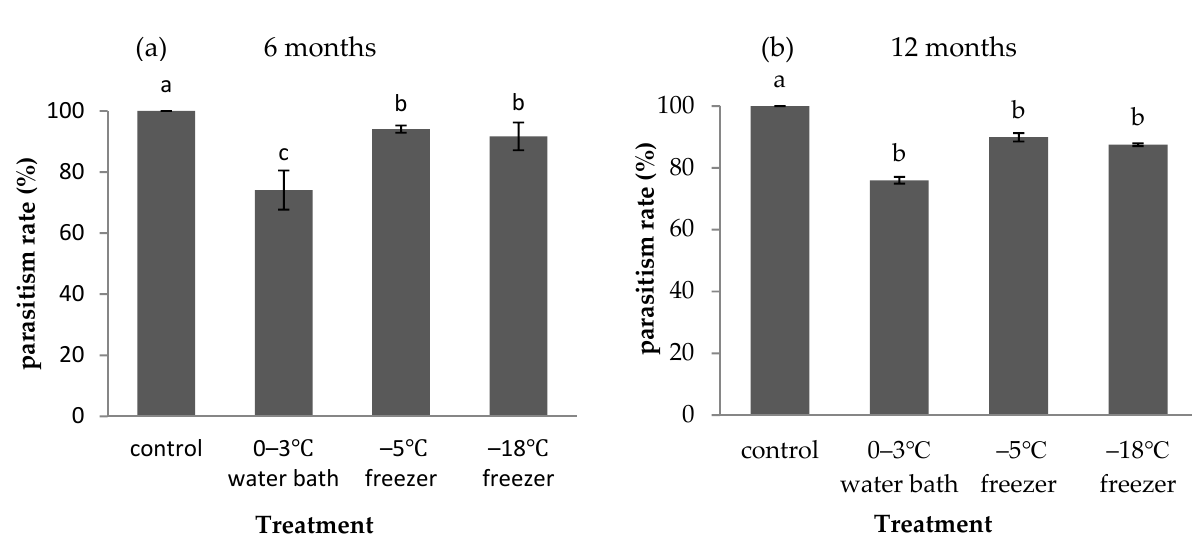
(F = 27.142, df = 3,8, p < 0.001, Figure 6b). There was no significant difference in overall should not be stored for more than 6 months.